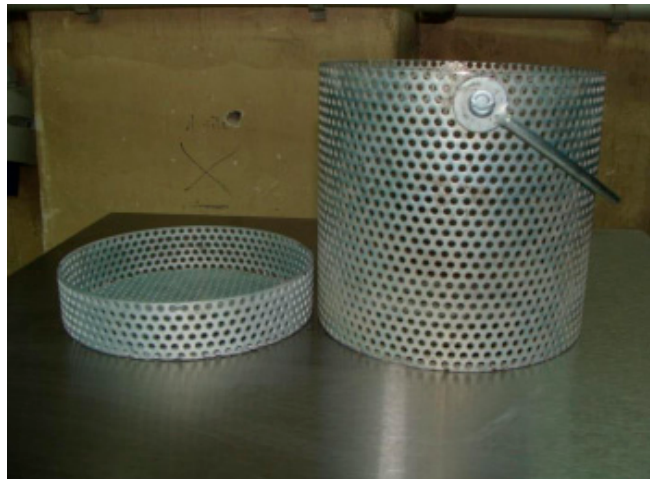
Figure 3. Concrete mix container for wash-out loss testing.